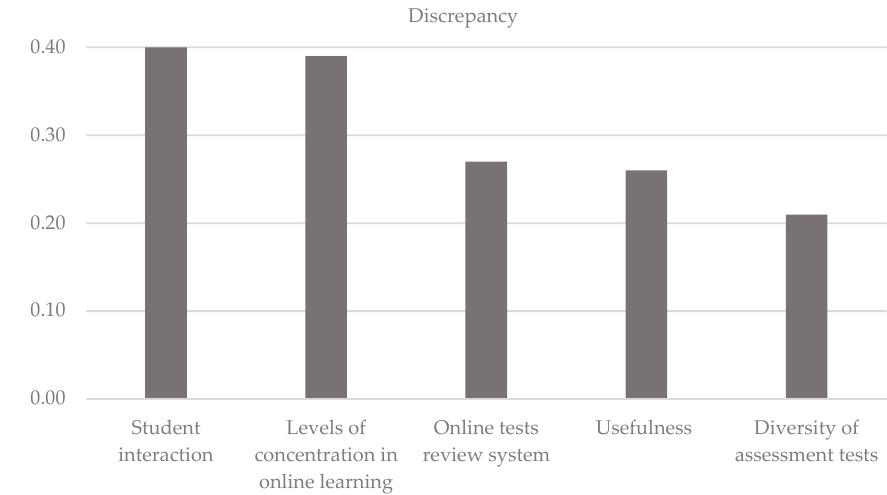
Figure 3. Representation of the five priority attributes.